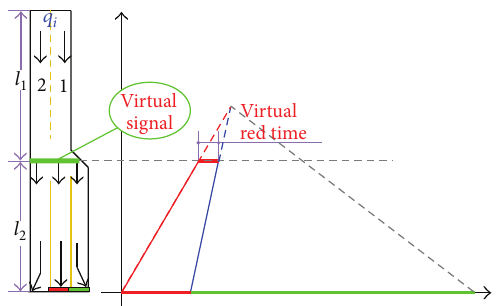
Figure 21: Critical split for jam formation versus different entrance position (𝑙 𝑑 ) , 𝑞 𝑖 = 500 veh/h, 𝑞 𝑒 = 300 veh/h.